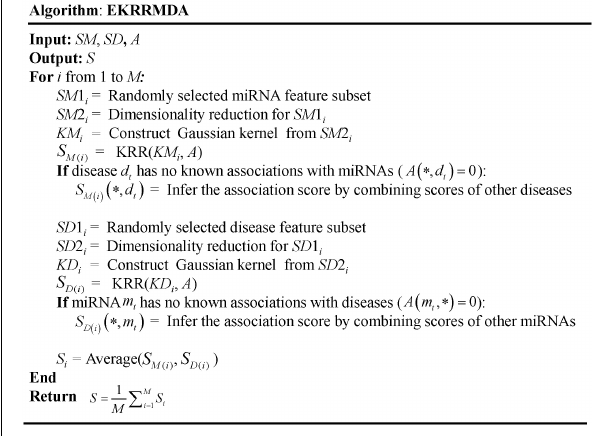
FIGURE 2 | The pseudocode of